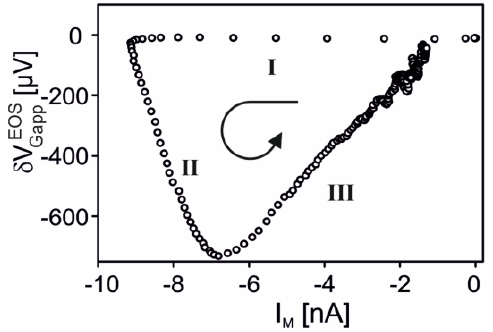
Figure 13. Transistor recording of the serotonin receptor 5-HT3A in a HEK293 cell for constant intracellular voltage (by permission [5]). The apparent change of the gate voltage δ V EOS is plotted Gapp versus the whole-cell current I M upon fast addition of 100 µ M serotonin at an intracellular voltage of − 120 mV . The time direction is indicated by the arrow (data interval 2.5 ms ). The recording is obtained with a low ion sensitivity of the gate oxide. Three phases are distinguished: (I) increasing whole-cell current without transistor signal (about 20 ms ); (II) decreasing whole-cell current and increasing transistor signal (about 70 ms ); and (III) decreasing whole-cell current and decreasing transistor signal.